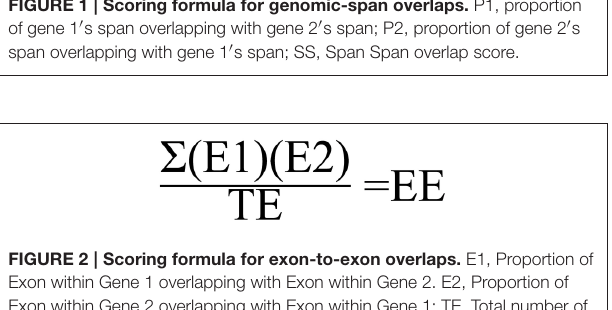
FIGURE 1 | Scoring formula for genomic-span overlaps. P1, proportion of gene 1 ′ s span overlapping with gene 2 ′ s span; P2, proportion of gene 2 ′ s span overlapping with gene 1 ′ s span; SS, Span Span overlap score.